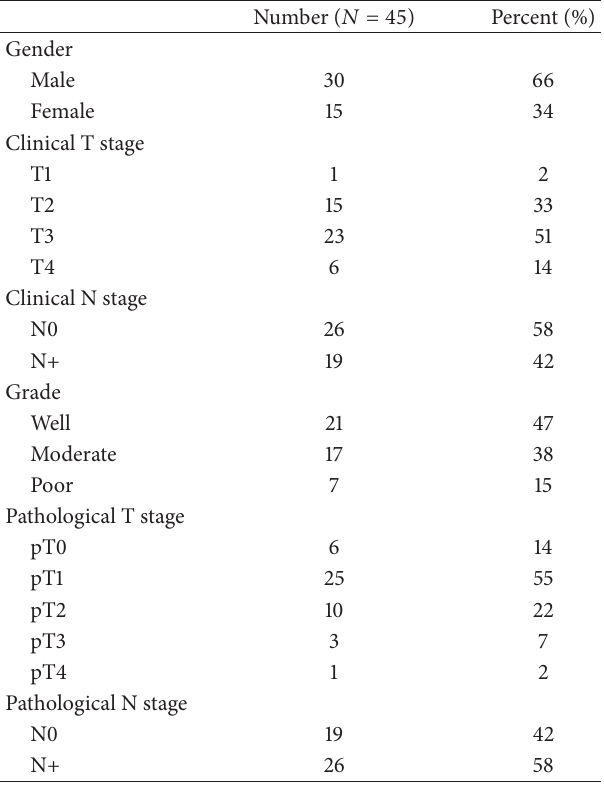
Table 4: Characteristics of patient who received induction chemo-